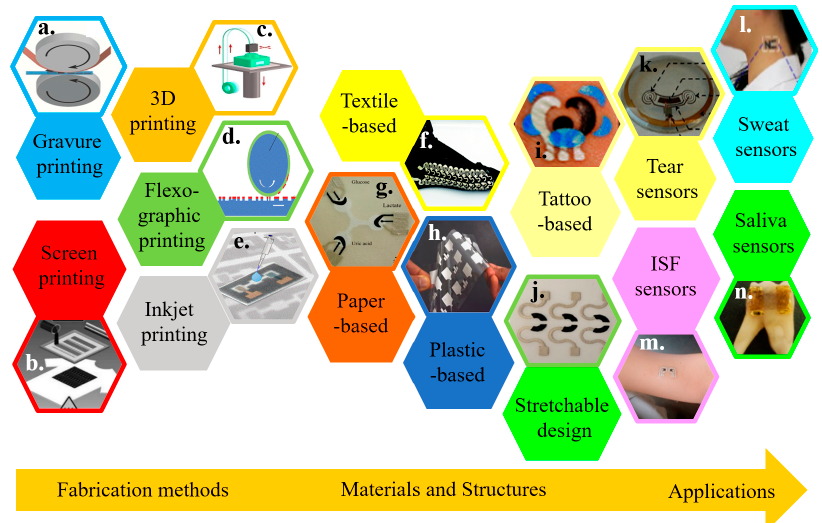
Figure 1. Overview of wearable electrochemical biosensors. Representative fabrication approaches